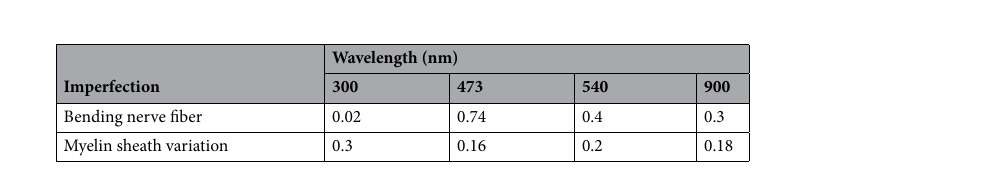
Table 5. Orders of magnitude the transmission for typical wavelengths in a bending nerve fiber and myelin sheath variation compared to a normal nerve fiber when light launched to Axon.